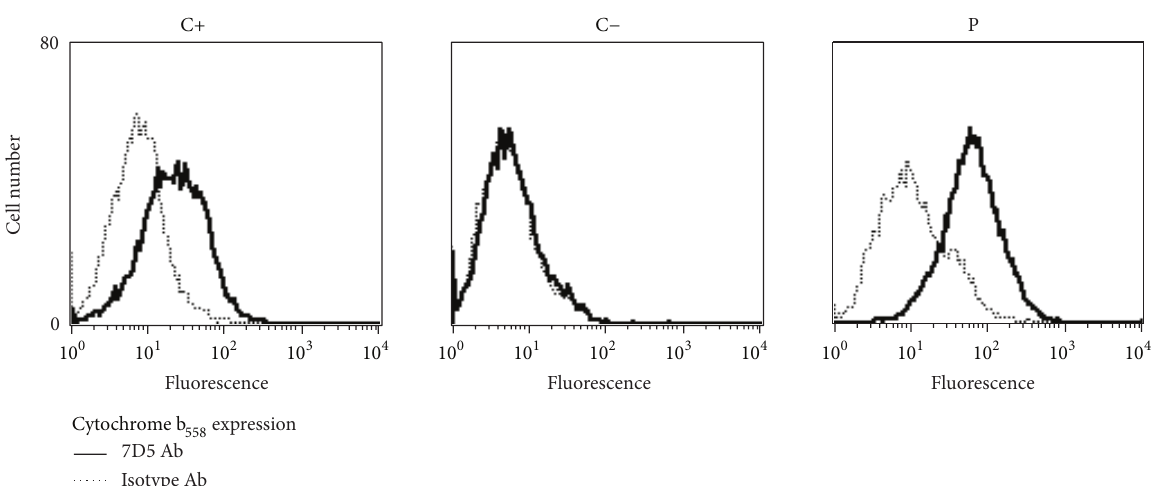
Figure 2: Expression of gp91 phox in a patient with the H338R CYBB mutation. Immunostaining of cytochrome b 558 in EBV-B cells from a healthy control (C+), an X-linked CGD patient (C − ), and the patient (P). Cell surface staining with mAb7D5 (an antibody specific for the extracellular epitope of gp91 phox ; solid lines); an isotype IgG1 (dotted lines) followed by staining with an Alexa Fluor 488 goat anti-mouse Ig secondary antibody. The results shown are representative of two independent